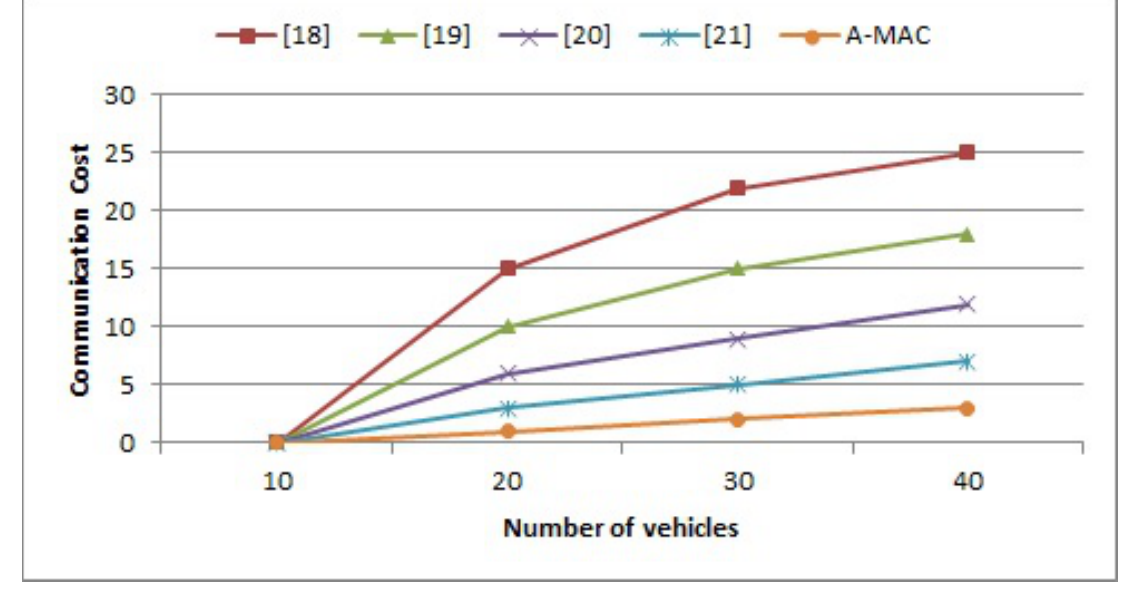
Figure 5. Communication cost.